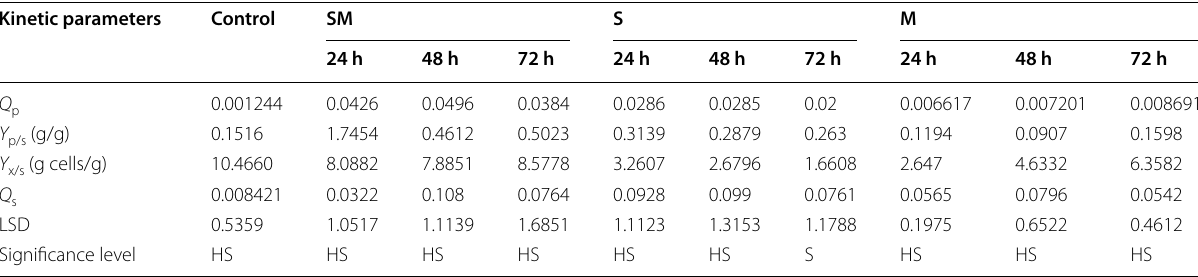
Significant differences were determined by one-way ANOVA followed by LSD post hoc test using software SPSS, version 16.0, (SPSS Inc., Chicago, IL, USA). Differences were considered to be significant at p < 0.05 HS highly significance, S significance SM SVH and methanol, S SVH, M methanol